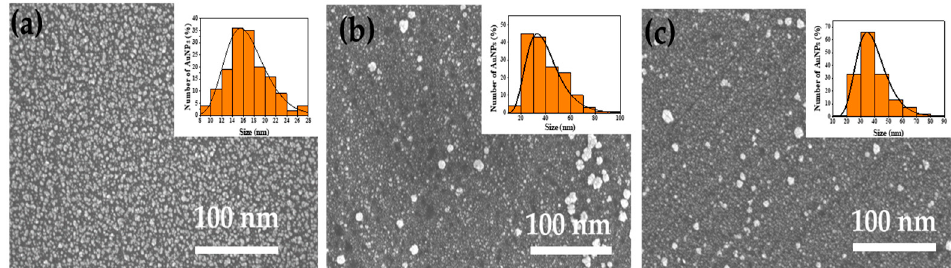
Figure 2. SEM images of Au-NPs deposited on the surface of c-Si wafers for different deposition times: ( a ) 10 s, ( b ) 20 s, and ( c ) 30 s. The corresponding size of distribution for Au-NPs (orange bars) and their fits by log-normal functions (solid line) are shown in the insets.